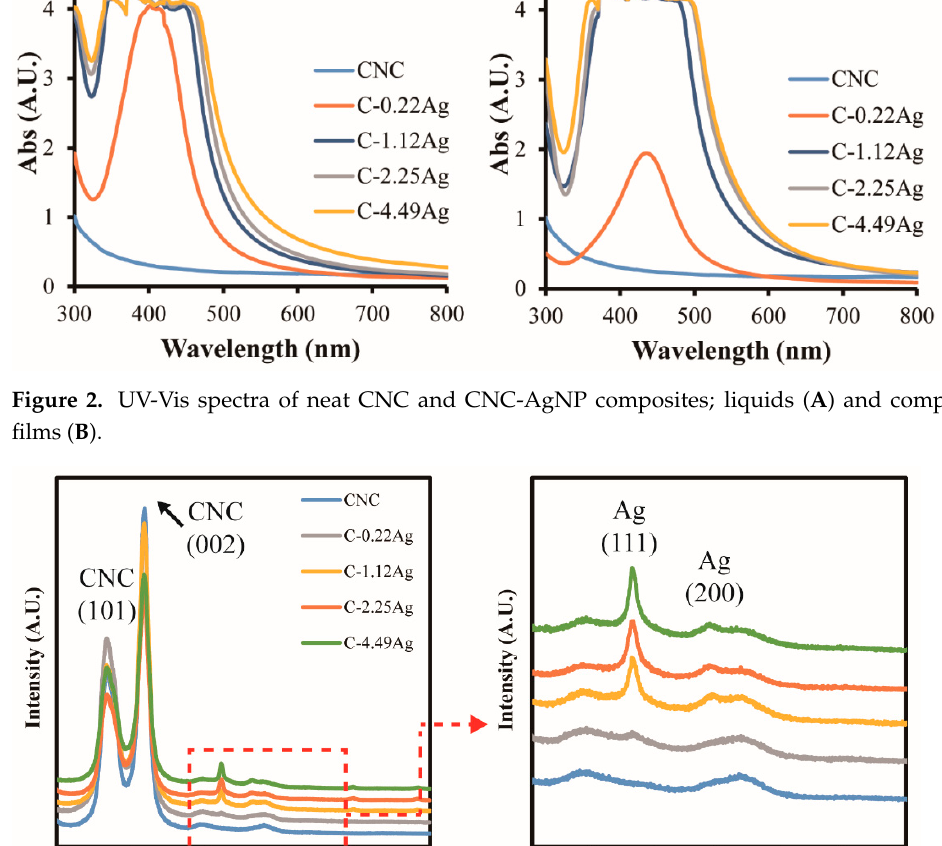
Figure 2. UV-Vis spectra of neat CNC and CNC-AgNP composites; liquids ( A ) and composite films ( B ).